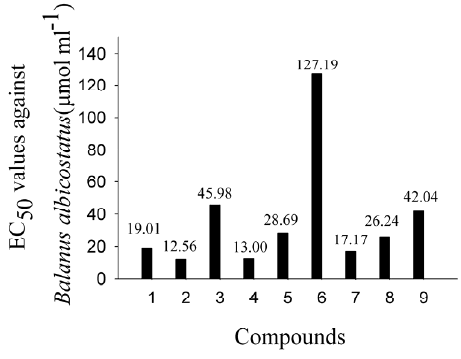
Figure 1. EC values of Compounds 1 – 9 against larval settlement of B. albicostatus . 50